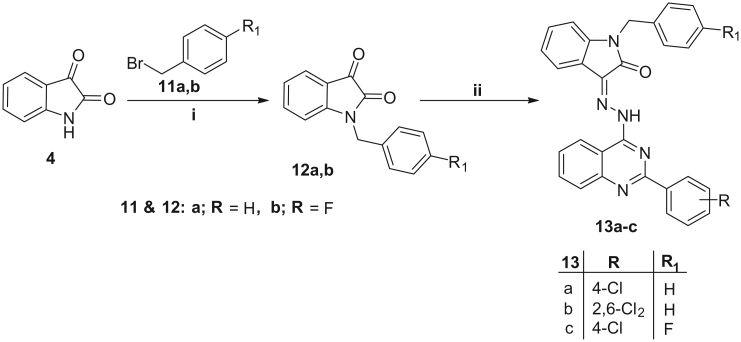
Reagents and conditions: i, DMF/K2CO3/reflux 3 h; ii, Compounds 4a,b/EtOH/AcOH (catalytic)/reflux 0.5 h.